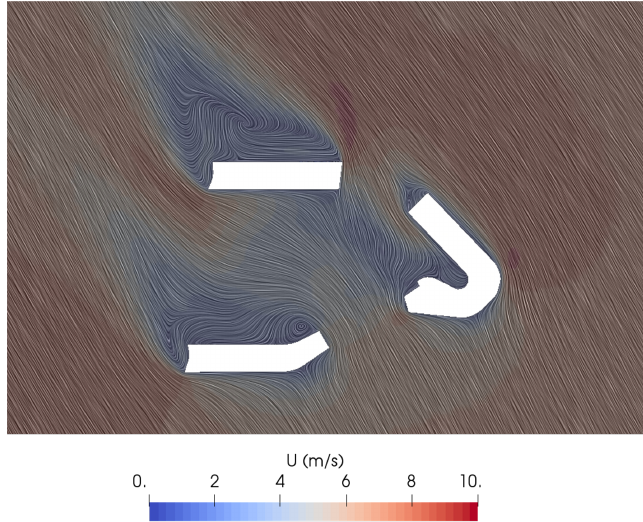
Figure 22. Velocity field on ENI Head Office, at height 0.5 m model